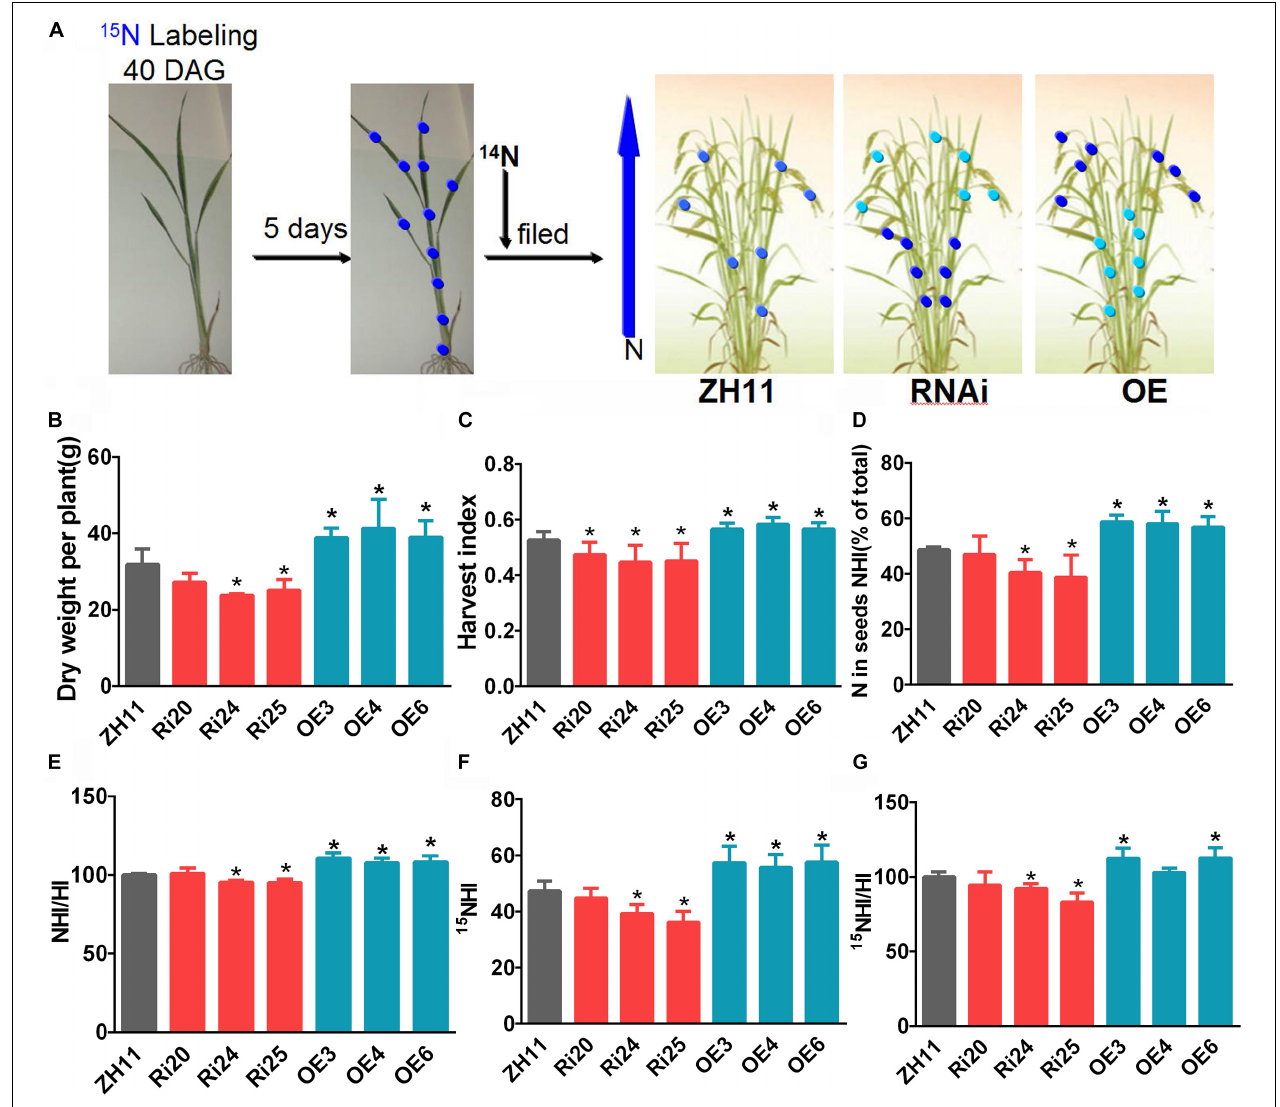
FIGURE 7 | OsATG8b -mediated autophagy significantly affects N recycling efficiency (NRE). OsATG8b -RNAi (Ri) and OsATG8b -OE (OE) lines and ZH11 were grown in IRRI solution with 14 NO 3 - supplementation until 40-day after germination and then labeled by a 5-day pulse of 15 NO 3 - and subsequently grown in normal conditions to mature stage. After grain filling, 15 N and the 14 N/ 15 N ratio were analyzed by isotopic ratio mass spectrometry. (A) Overview of 15 N labeling and subsequent N partitioning. The deeper the blue of the dot, the higher the N content. (B) Biomass accumulation as measured by dry weight (DW) per plant. (C) Harvest index (HI) as measured by ratio of DW of grains to DW of the aboveground plant parts. (D) Nitrogen harvest index (NHI) as measured by the partitioning of total plant N in grains. (E) NHI:HI ratio as an estimate of N use efficiency. (F) Partitioning of total 15 N in grains. (G) 15 NHI:HI ratio as an indicator of N recycling efficiency. Three biological replicates, each containing five plants, were used for data analysis. Results are the mean ± SD from five plants. * p < 0.05 ( t -test): significantly different from